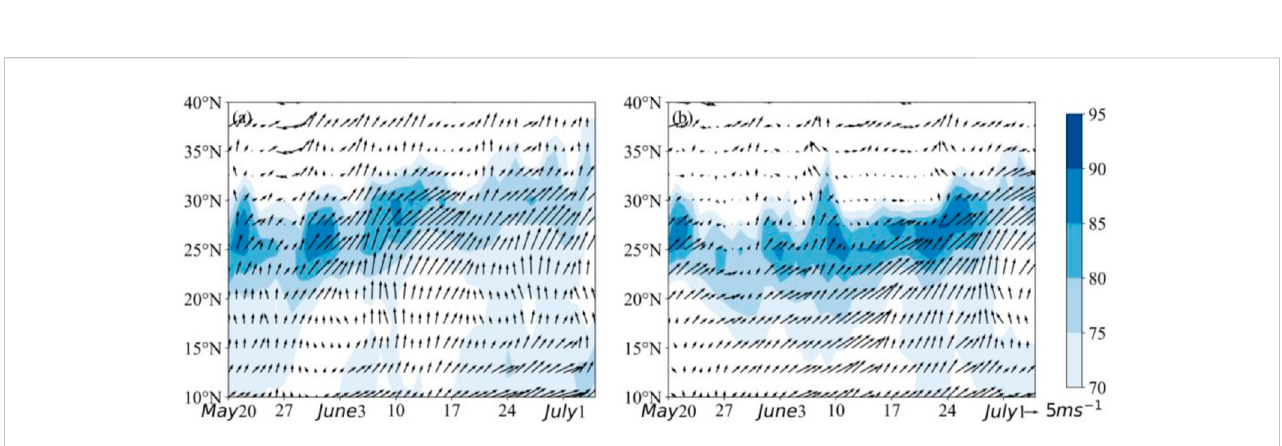
FIGURE 7 110 ° -120 ° E average of 850 hPa relative humidity (shadow, unit: %) and wind fi eld (unit: m/s) time-latitude cross sections in the early and late years of Meiyu onset (A) : early years (B) : late